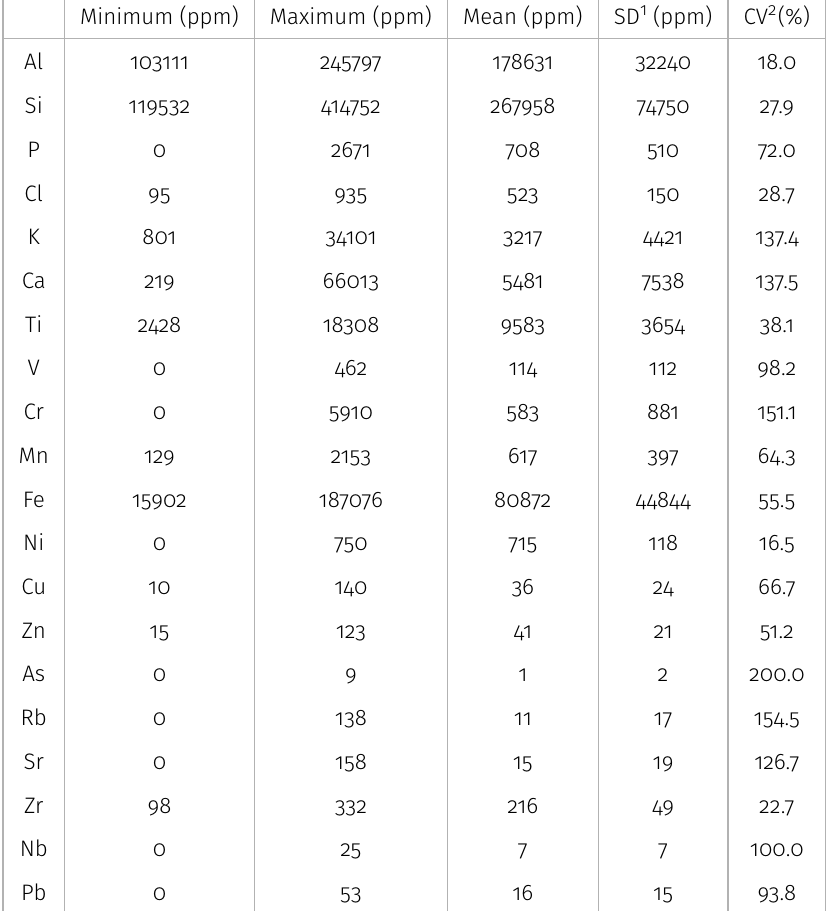
Table II. Descriptive analysis of data obtained via pXRF for soils sampled at Lavras, Minas Gerais, Brazil.